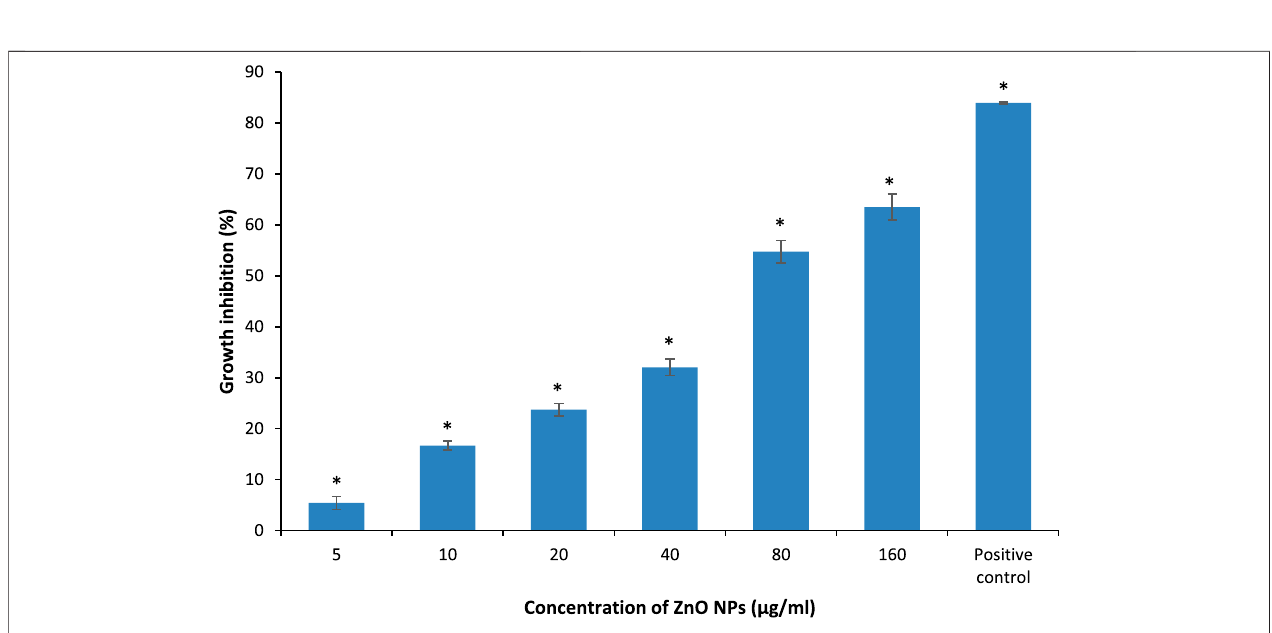
FIGURE 5 | Percentage of growth inhibition on E. faecalis upon treatment with different concentrations of ZnO NPs for 24 h at 35 ° C in LB broth. * indicates the signi fi cant difference between the negative control and the bacterial suspension treatment with different concentrations of ZnO NPs at p < 0.05.